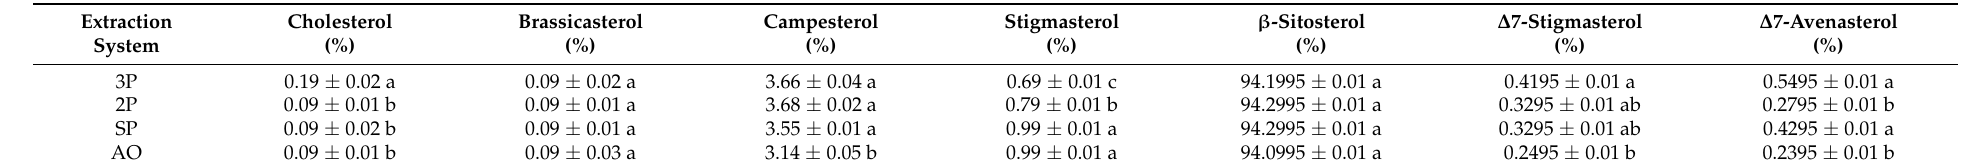
Table 3. Mean values of sterols in olive oil (cv ‘Moroccan Picholine’) according to extraction system. Results are expressed as mean ± SD (n = 9). Within each column, values followed by the same letter are not significantly different at p <